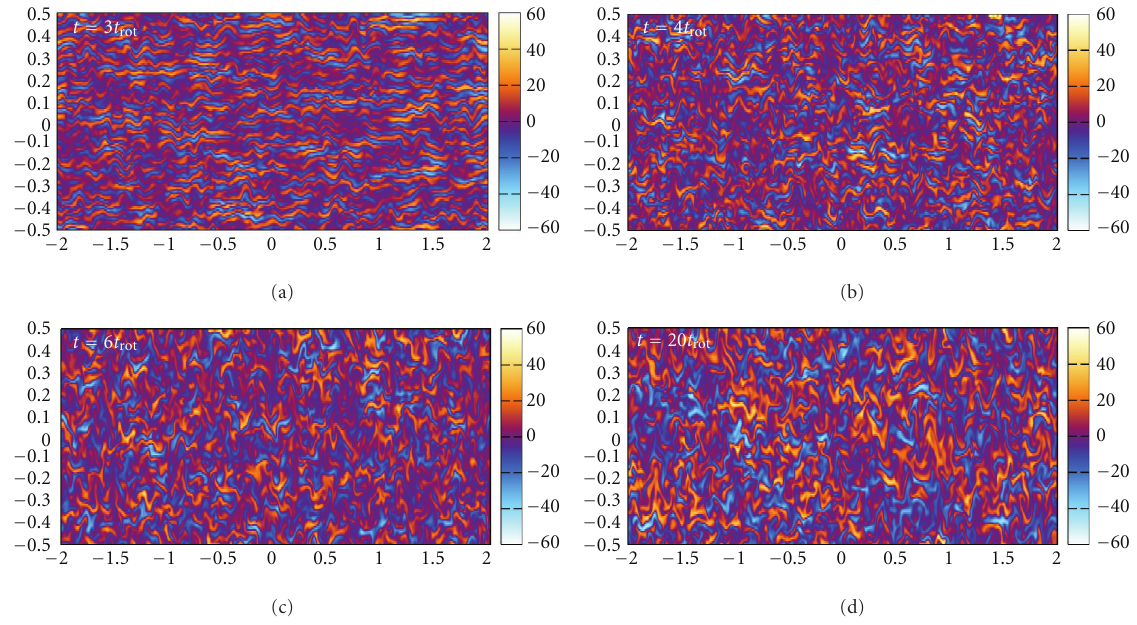
Figure 20: Four snapshots representing the temporal evolution of MRI from the linear to the nonlinear phase. Panels (a), (b), (c) and (d) correspond to the time slice t = 3 t rot , 4 t rot , 6 t rot , and 20 t rot respectively. The color bar indicates the size of the toroidal magnetic field normalized by the strength of the initial vertical magnetic field ( B 0 = 1 . 4 × 10 12 G). Note that the vertical and horizontal are normalized by the typical spatial scale of the local portion in the protoneutron stars which is selected as L = 1km in the fiducial run. Three typical evolutionary stages are observed, (i) exponential growth stage, (ii) transition stage, and (iii) nonlinear turbulent stage (compare with Figure 19).